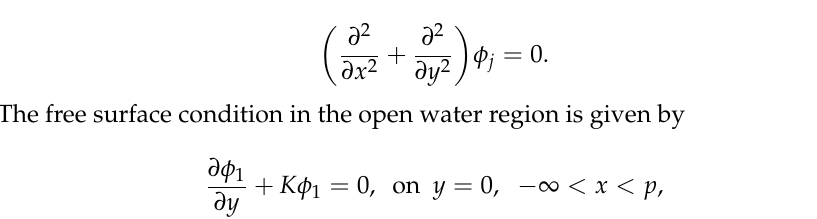
Figure 1. Schematic of wave motion over undulated bed and floating elastic